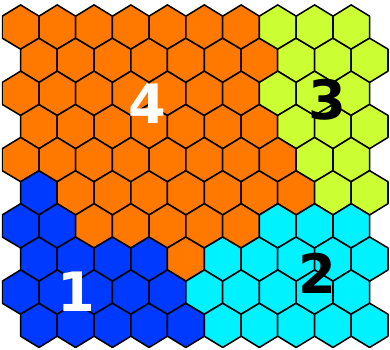
Fig. 8. The distribution of the 4 classes presented in Fig. 7 on SOM.